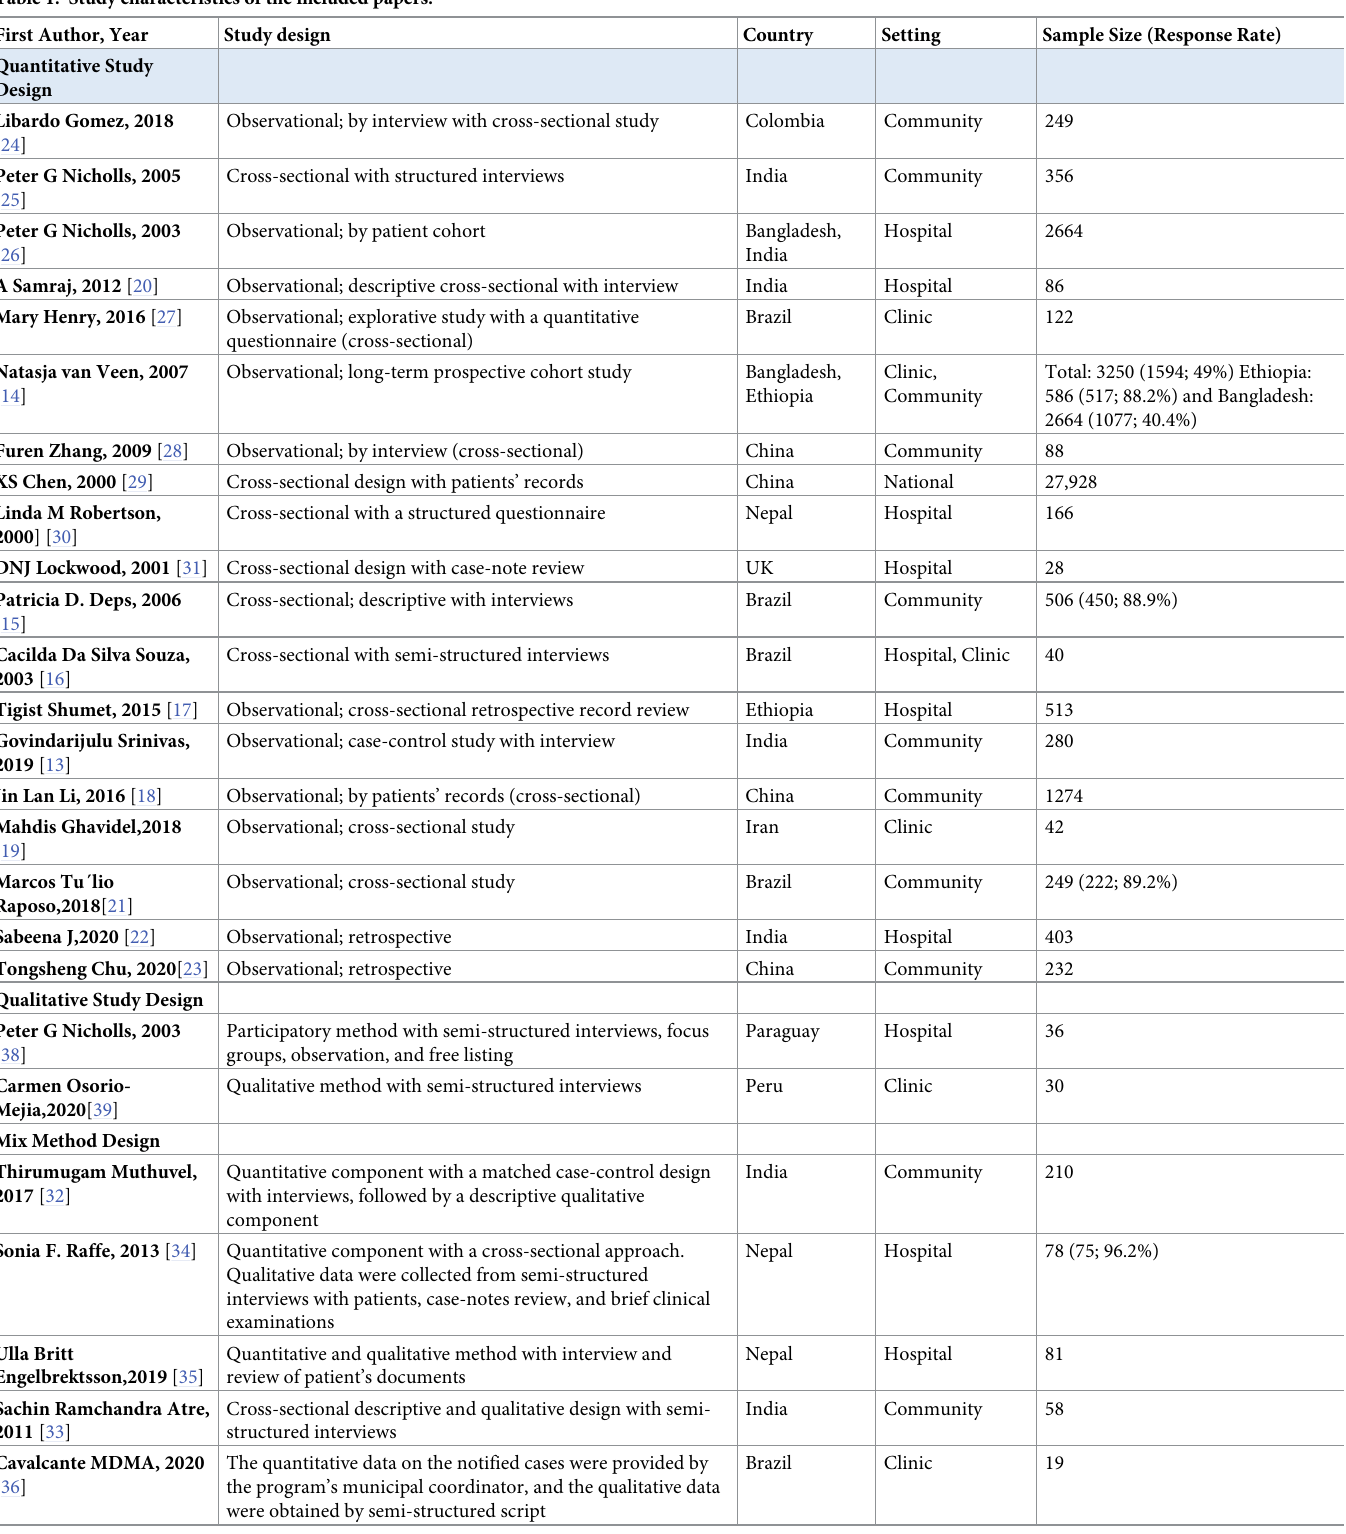
Table 1. Study characteristics of the included